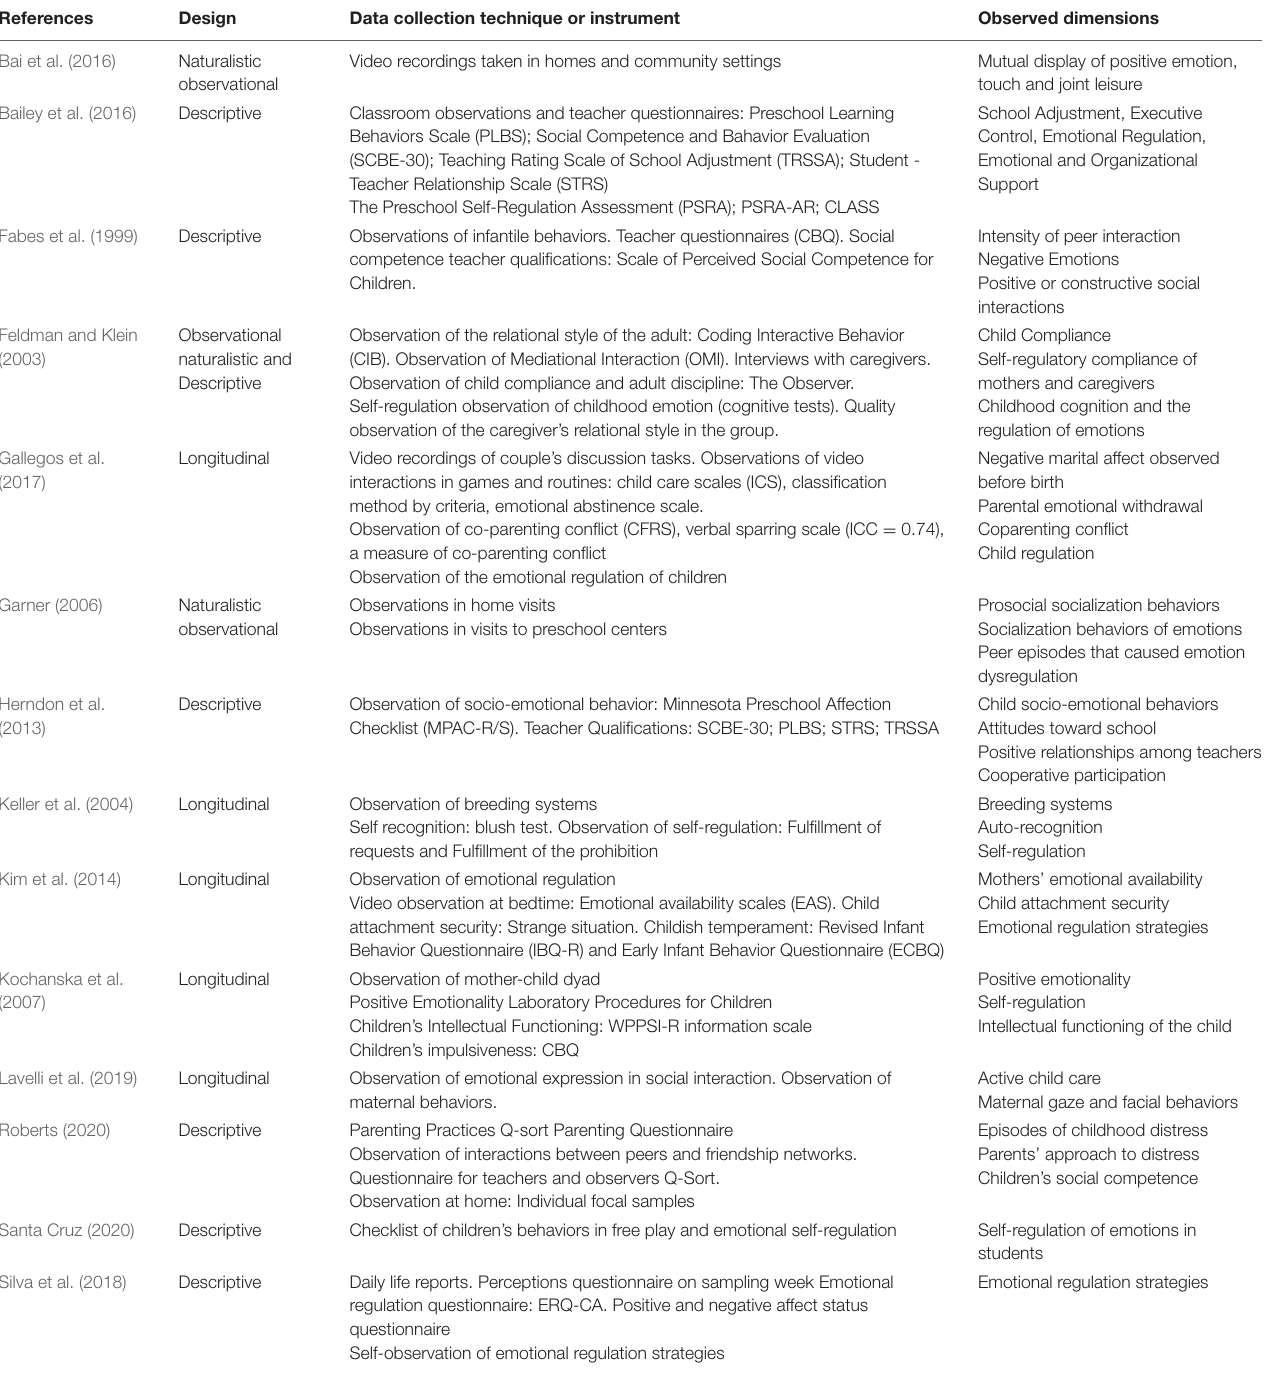
TABLE 4 | Methodological characteristics declared by the